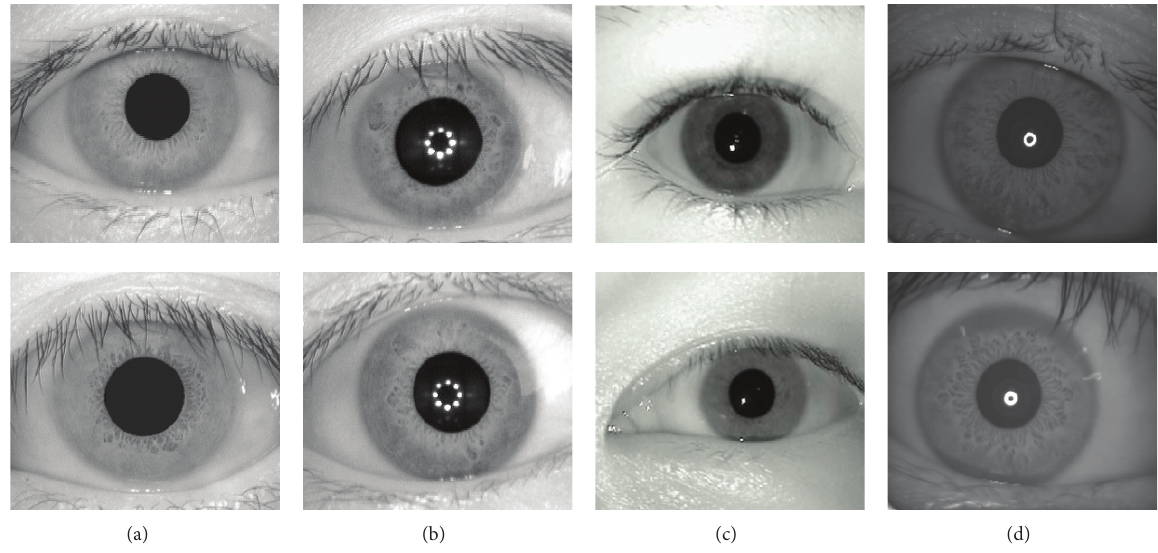
Figure 8: Sample images from CASIA-V1, CASIA-V3 Interval, MMU-V1, and JLUBRIRIS-V1 databases. (a) CASIA-V1, (b) CASIA-V3 Interval, (c) MMU-V1, and (d)